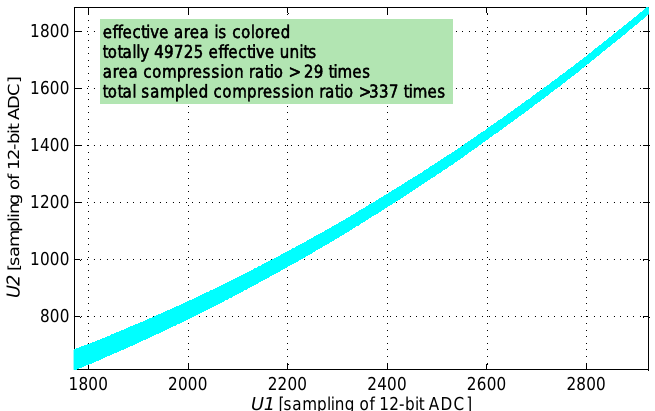
Figure 9. Effective table area according to the domain of the engineering